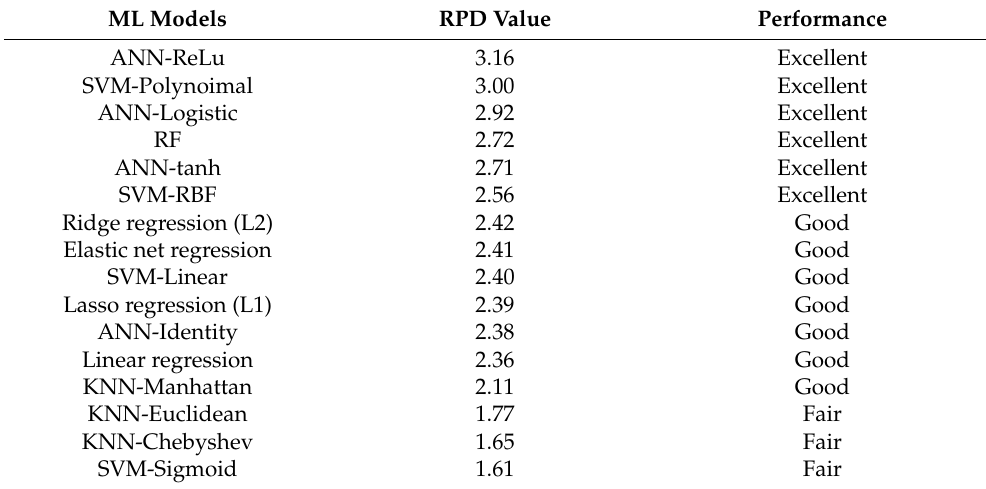
Table 3. The ratio of percent deviation (RPD) performance of ML models developed for DWGR prediction. ML Models RPD